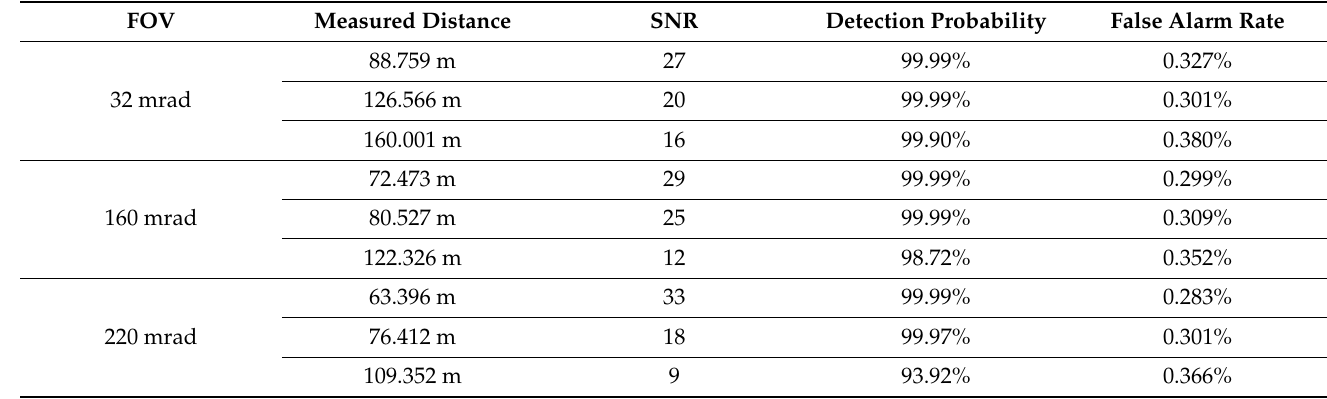
Table 3. Detection probability and false alarm rate at different distances and fields of